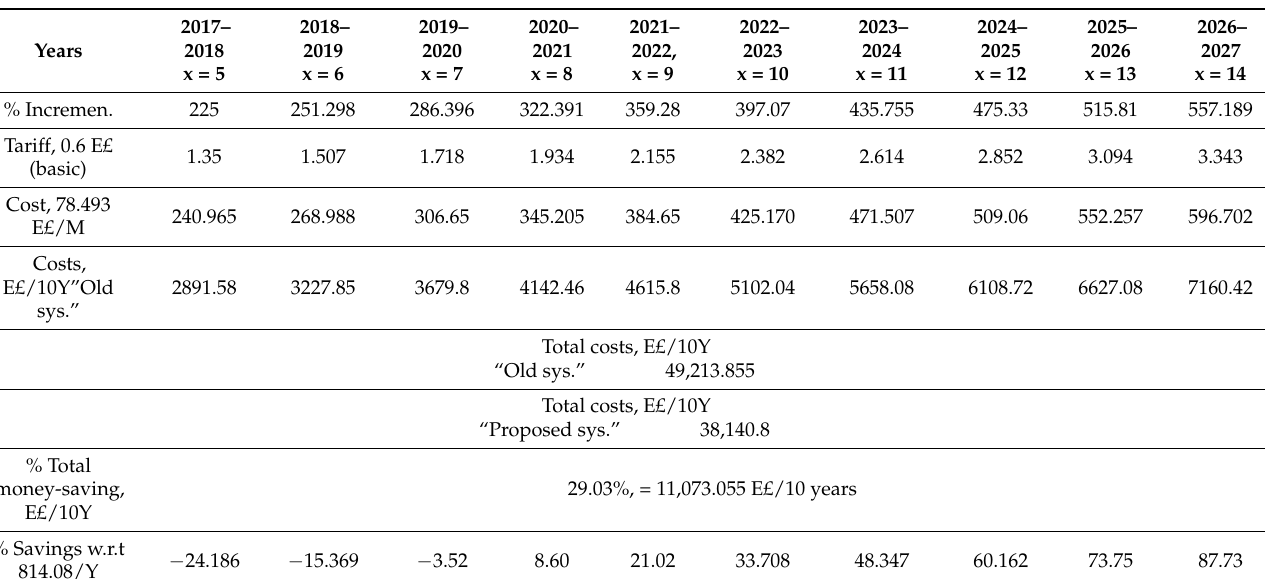
Table 7. Incriminations, strip costs, and % savings for each family (5 persons) with proposed methodology through 10 years for residential loads “from 2017/2018 to